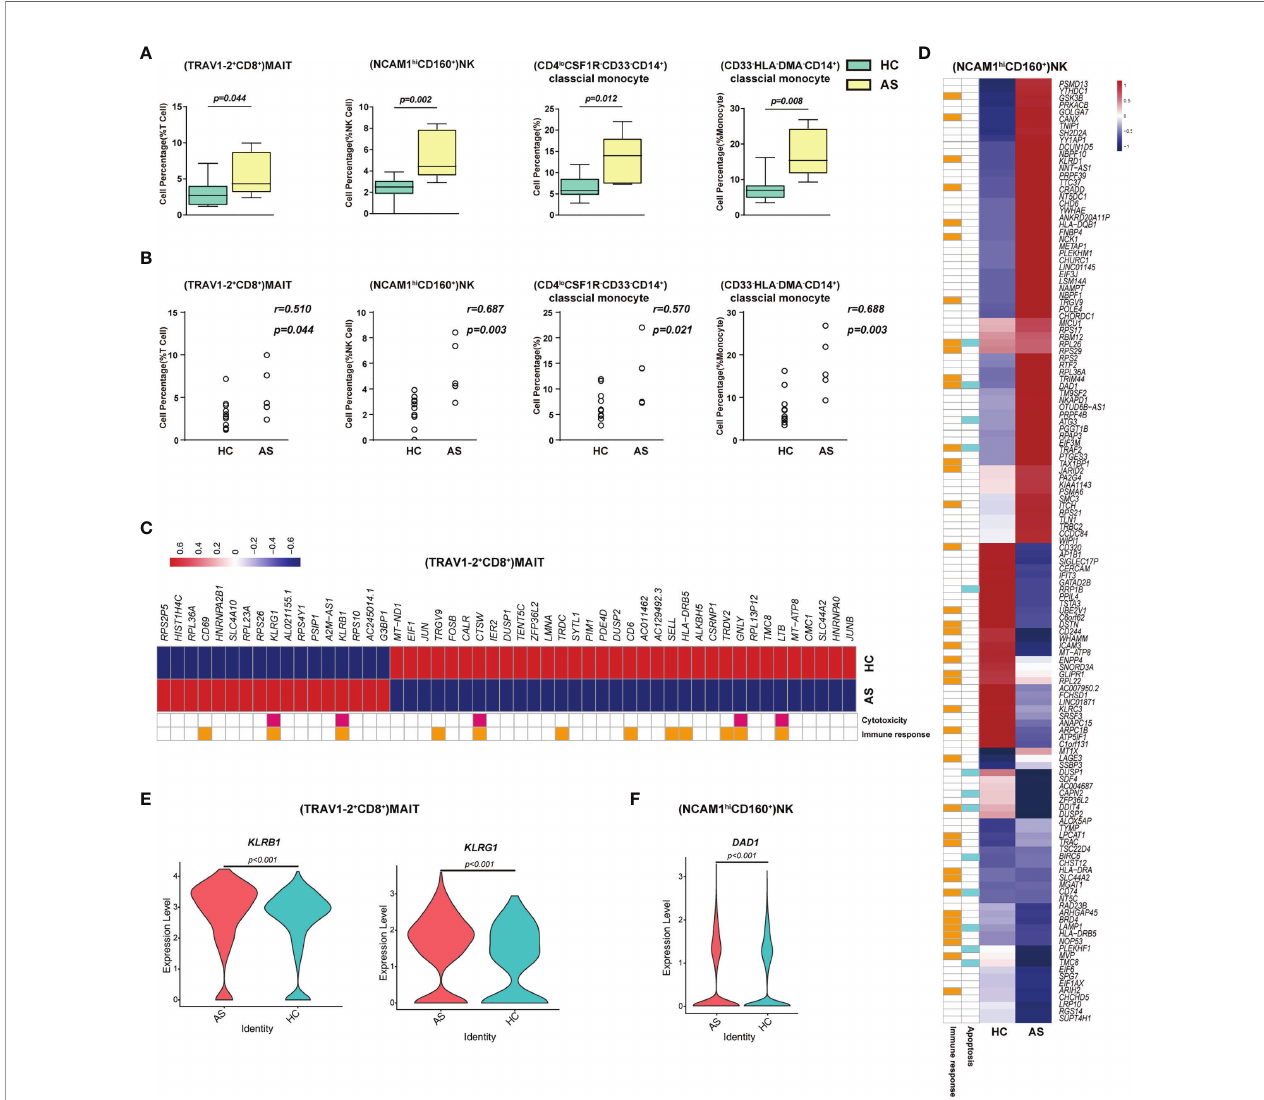
FIGURE 3 | Immune cell subsets associated with asymptomatic COVID-19 patients. (A) The Box and whisker plots showing the percentage of four cell clusters that had signi fi cant differences (p <0.05) HC and AS groups. The horizontal lines, box and whiskers correspond to median values, interquartile range (IQR) and minimum/ maximum value, respectively. (B) Spearman rank order correlation analysis showing the percentage of the four cell types described above are positive associated with the asymptomatic state (C) A Heatmap showing the average level of the differentially expressed genes (DEGs) in the (TRAV1-2 + CD8 + )MAIT cells with p <0.05 and log2 fold change (FC) ≥ 0.26 in HC and AS. The gene function (immune responses and cytotoxicity) is indicated in the heatmap. The gene expression was calculated via LogNormalize method of the “ NormalizeData ” function of the Seurat software. (D) A Heatmap showing the average level of the DEGs in the (NCAM1 hi CD160 + )NK cells with p <0.05 and log2 fold change (FC) ≥ 0.26 in HC and AS. The gene function (immune responses and apoptosis) is indicated in the heatmap. The gene expression was calculated via LogNormalize method of the “ NormalizeData ” function of the Seurat software. (E) The violin plot showing the expression levels of two representative DEGs ( KLRB1 and KLRG1 ) in (TRAV1-2 + CD8 + )MAIT cells, which was involved in cytotoxicity and/or immune responses. (F) The violin plot showing the expression levels of one representative DEG ( DAD1 ) in (NCAM1 hi CD160 + )NK cells, which was involved in apoptosis and/or immune responses (also see Figure S3 ). p <0.05 was considered signi fi cant. The samples included HC (n=11) and AS